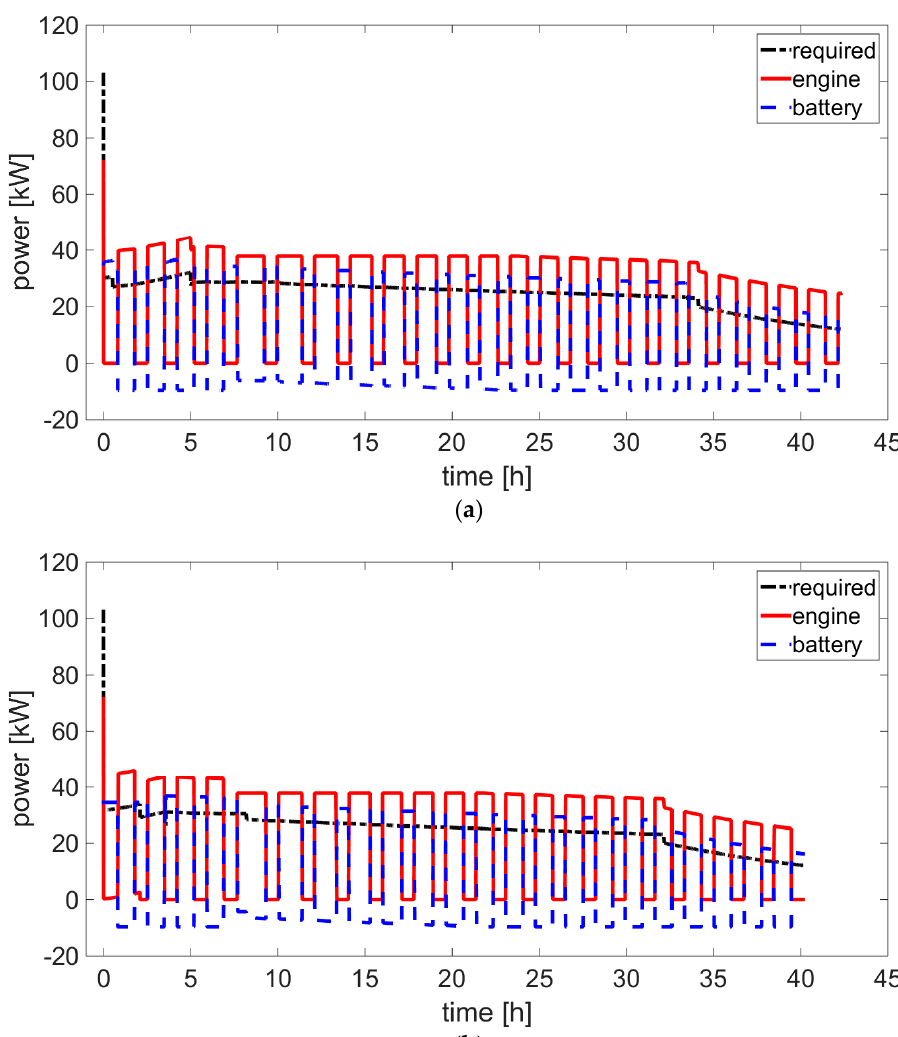
Figure 14. Usage of engine and battery in the optimal tradeoff solution. ( a ) Optimal mission; and ( b ) baseline mission .